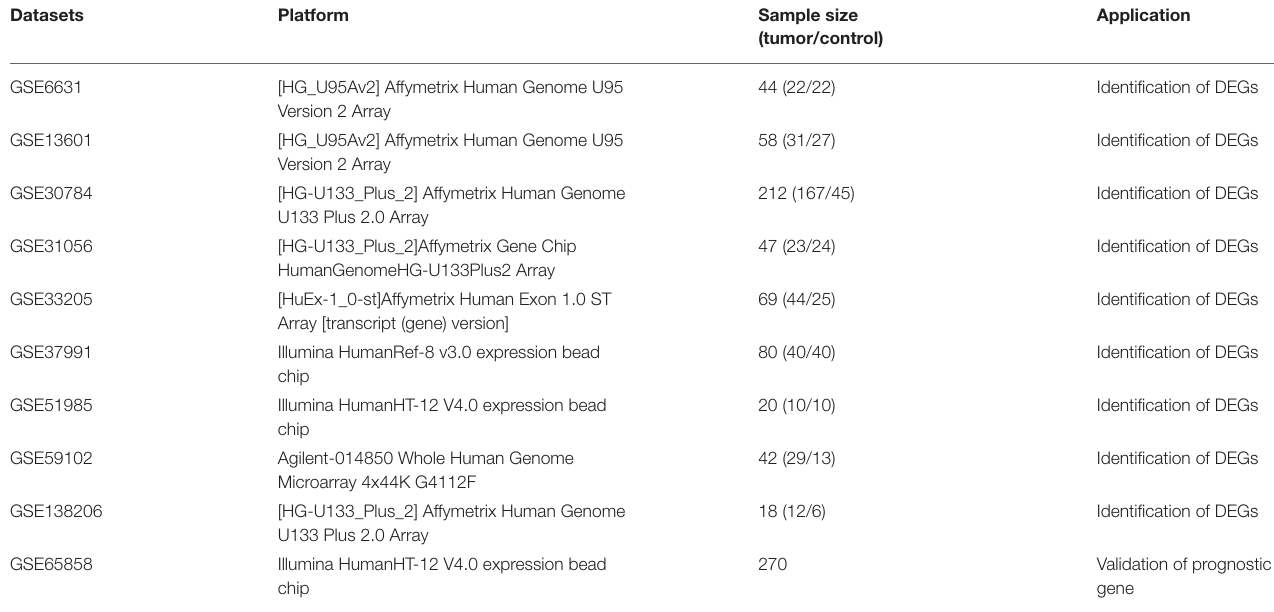
TABLE 1 | Details of the GEO datasets included in this